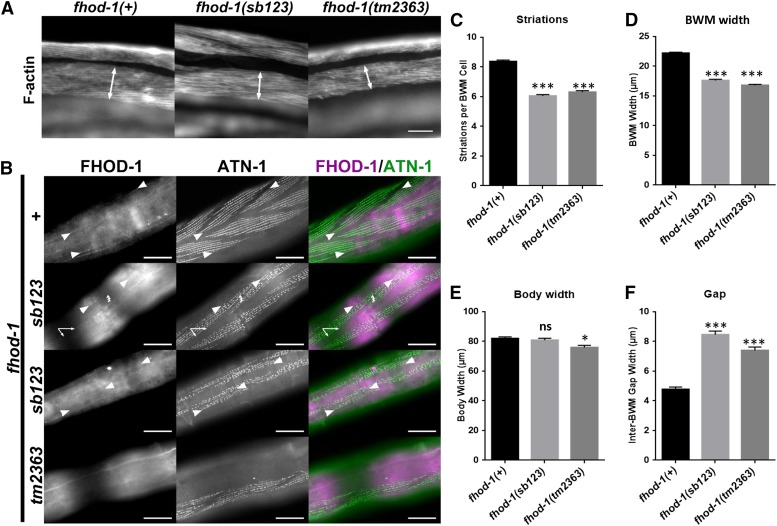
Muscle defects in fhod-1(sb123), which encodes only the short isoform, are as severe as the null allele fhod-1(tm2363). (A) Fluorescent phalloidin-stained F-actin in young adult stage animals. The arrow indicates the width of body wall muscles (BWM), which have fewer (C) and narrower (D) striations in both sb123 and tm2363. (B) L4 larva stage animals double-stained for FHOD-1 and Z-line marker ATN-1, showing that FHOD-1 is expressed in puncta along the edges of F-actin–rich body wall muscles cell contractile lattices (large arrowheads) and in faint striations across the lattices (small arrowheads). FHOD-1 levels are reduced in fhod-1(sb123) and absent in fhod-1(tm2363). The small arrows indicate non-specific stain by anti-FHOD-1 noted previously (Mi-Mi et al. 2012). Body width (E) was similar to wild type in both mutants while the gap between muscles (F) was similarly increased in both alleles. t-tests of mutants relative to wild type, * P ≤ 0.05, *** P ≤ 0.001, ns = P > 0.05, not significant. Scale bar, 100 µm.